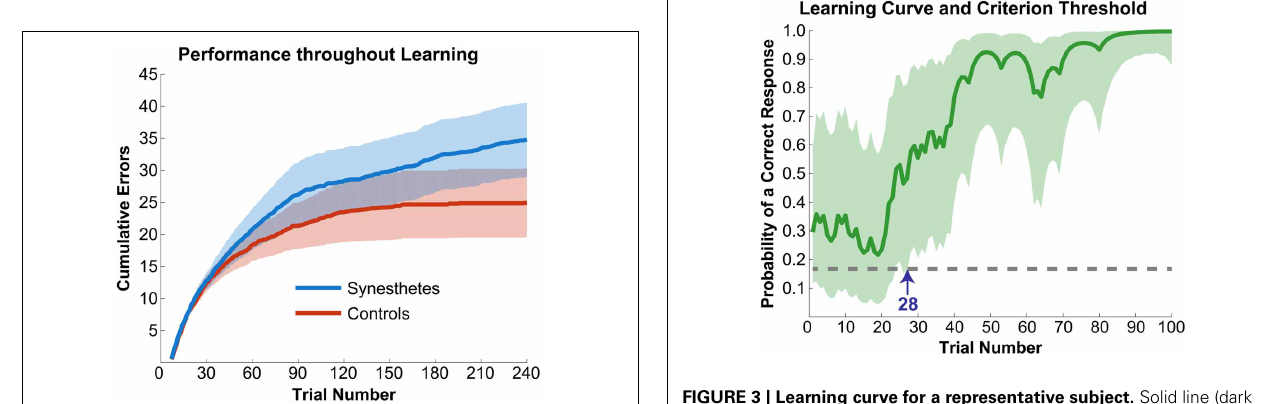
FIGURE 3 | Learning curve for a representative subject. Solid line (dark green) reflects the probability of a correct response on any given trial. The light green cloud reflects the 95% confidence interval for this probability. Learning criterion was reached when a subject’s accuracy exceeded chance (dotted gray line) with 95% certainty (marked with the blue arrow at trial number 28). The plot begins at trial number seven as the first six trials were guesses and were excluded from all analyses, and only shows results for trials up to 100 for illustrative